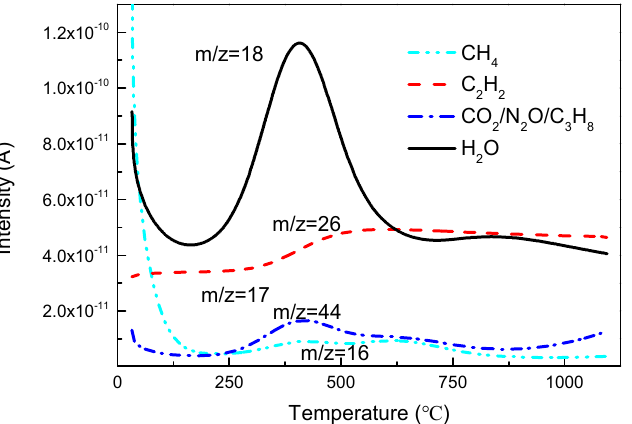
Figure 11. Intensity curves of m / z = 16, 18, 26 and 44 degradation products of the composite released during TGA (20 °C/min-inert atmosphere).